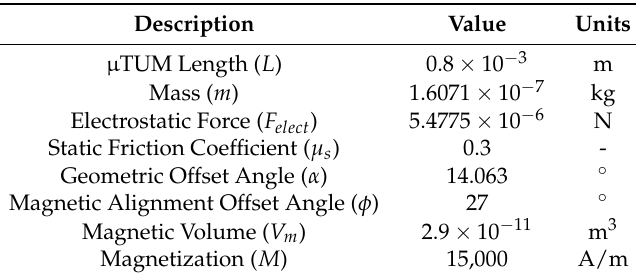
Table 1. Static inclination angle model parameters. The density of SU-8 (1190 g/m 3 ) and NdFeB (7500 g/m 3 ) were used to calculate mass.